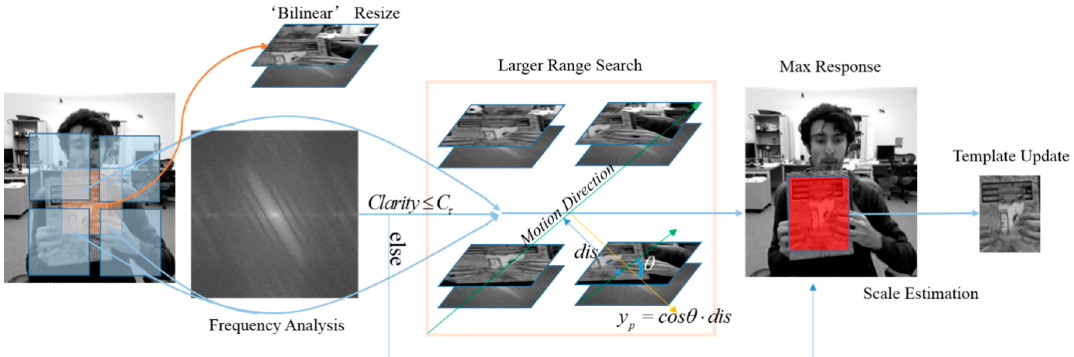
Figure 2. A brief illustration for our method.